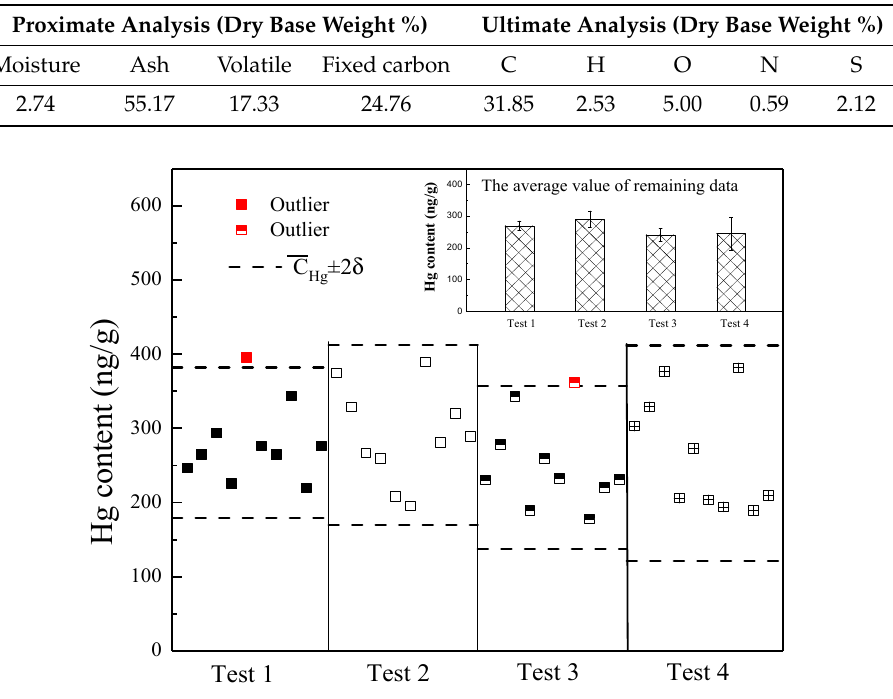
Figure 2. Hg contents in the feed fuel samples.